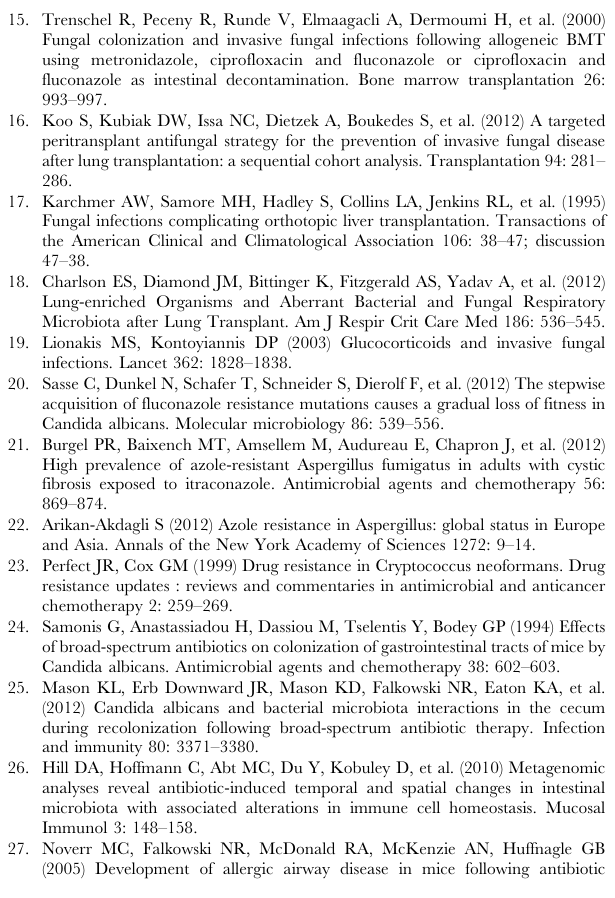
Table S3 Oligonucleotides used in this study.